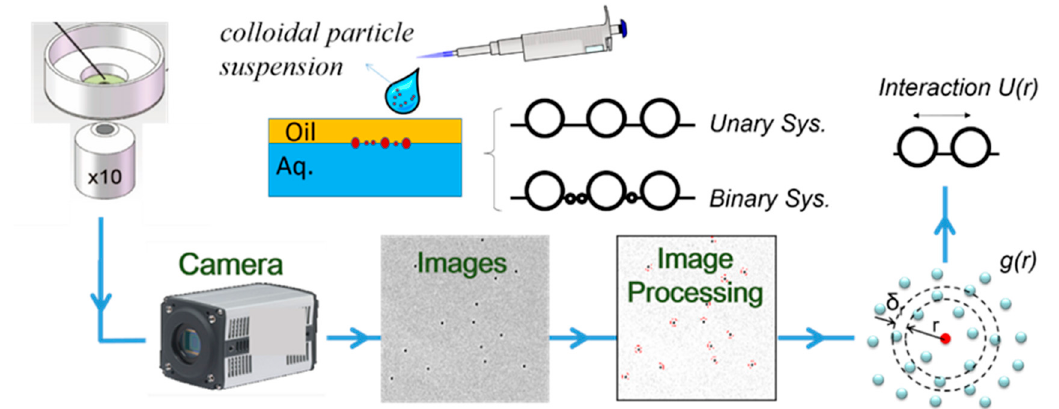
Figure 1. General method flow chart for measuring interaction potentials of colloidal monolayer and binary mixtures at the oil–water interface by recording images of interfacial particle monolayer, locating the particle via image processing, and calculating interactions between interfacial colloidal particles.